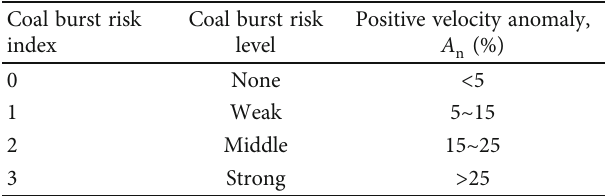
Table 3: Relation between positive velocity anomalies and coal burst risk